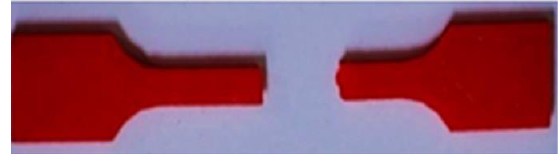
Figure 7. 3D printed ASTMD638 specimen after failure.